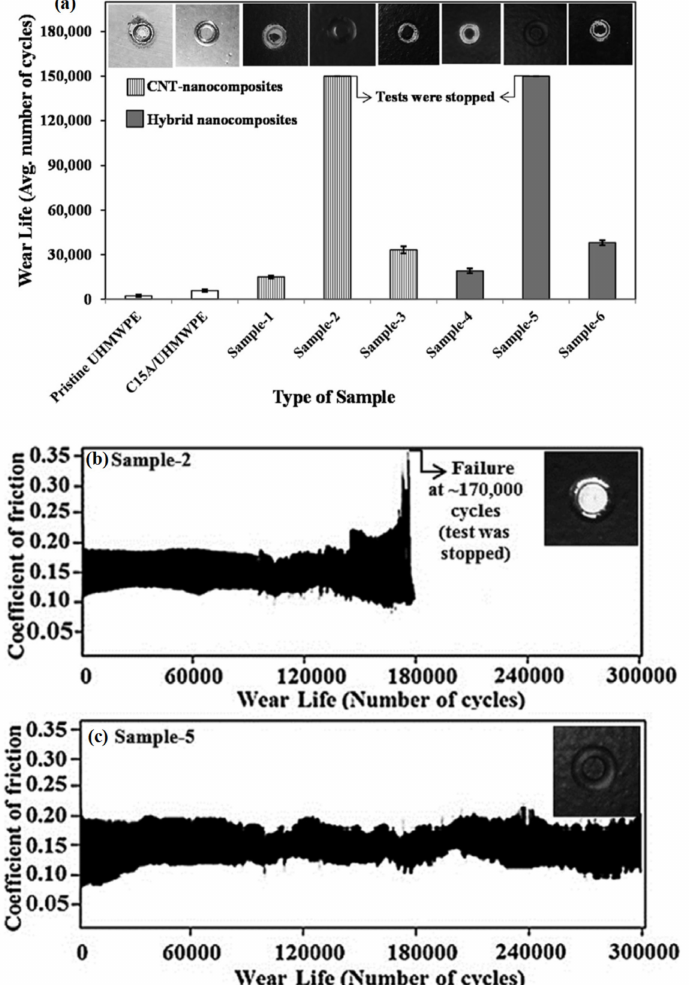
Figure 11. ( a ) Comparison of wear lives of different UHMWPE coatings: Sample-1 = UHMWPE/0.5 wt.% CNTs, Sample-2 = UHMWPE/1.5 wt.% CNTs, Sample-3 = UHMWPE/3wt.% CNTs, Sample-4 = UHMWPE/1.5 wt.% C15A/0.5 wt.% CNTs, Sample-5 = UHMWPE/1.5 wt.% C15A/1.5 wt.%